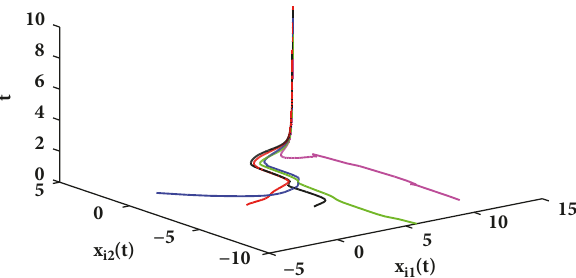
Figure 6: The states of five agents in two-dimensional